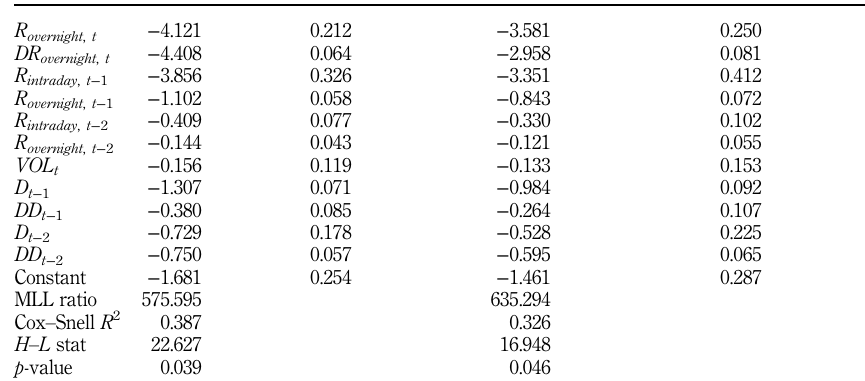
Table XII. Nested logit report on likelihood of floor hit in Regime 3